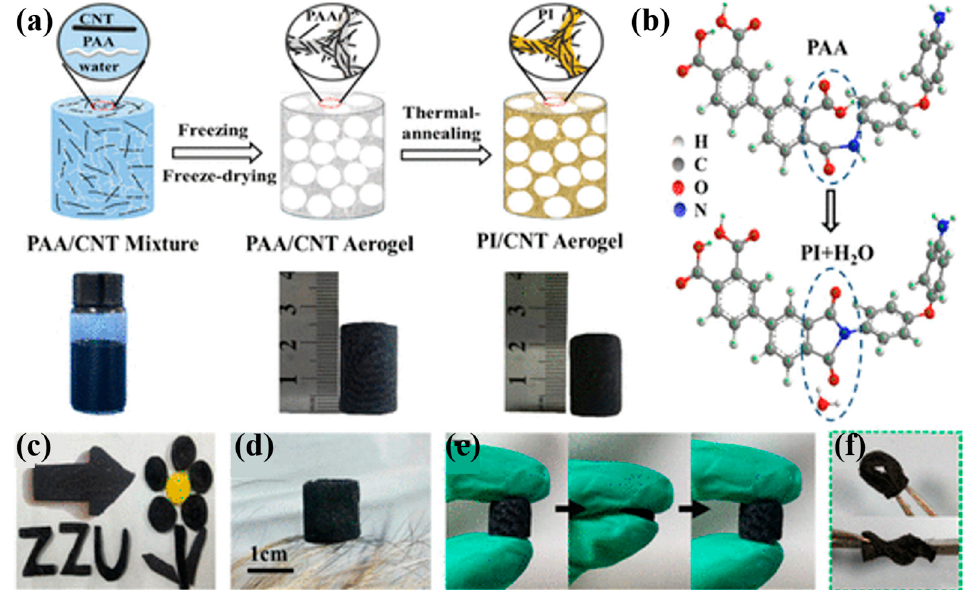
Figure 13. Schematic illustration of the ( a ) process of PI/CNT composite aerogel and ( b ) the thermal imidization process of PAA. Optical photograph of the ( c ) PI/CNT composites and ( d ) PI/CNT composites supported by wool. The composites withstand a high ‐ level ( e ) compression deformation and ( f ) bending and twisting. Reprinted with permission from Ref. [134]. 2019, ACS Publications.